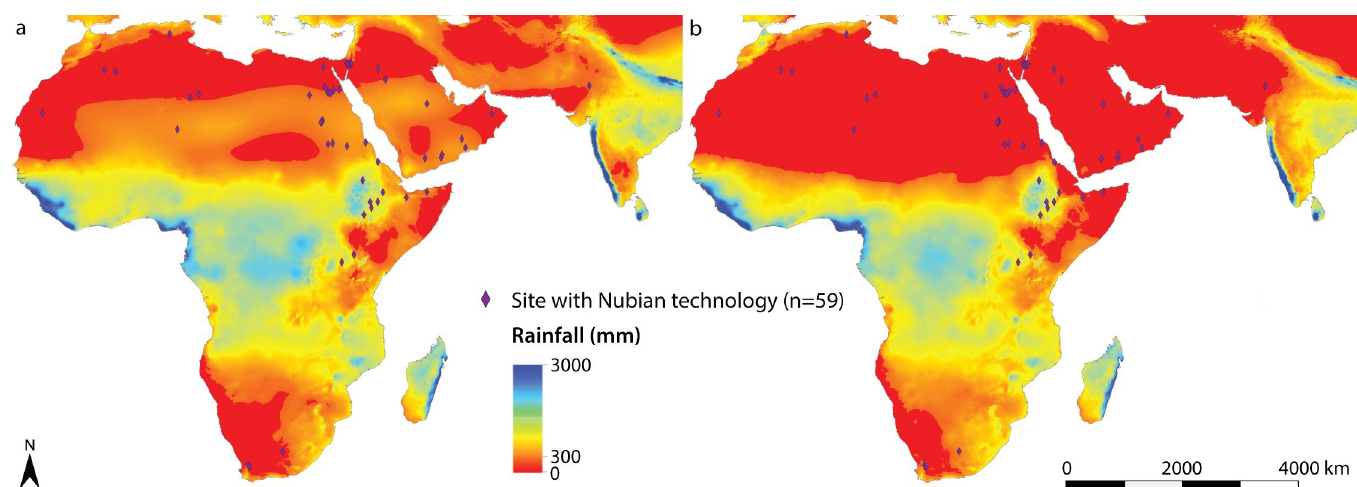
Fig 19. Sites with Nubian technology in relation to rainfall models. (a) Last Interglacial (140–120 ka, the age of many northern sites), and (b) Last Glacial Maximum (22 ka). Red areas receive less than 300 mm rainfall. Annual precipitation taken from bioclimatic data downloaded from Woldclim.org, after data from [143, 144]. Open- source spatial data from